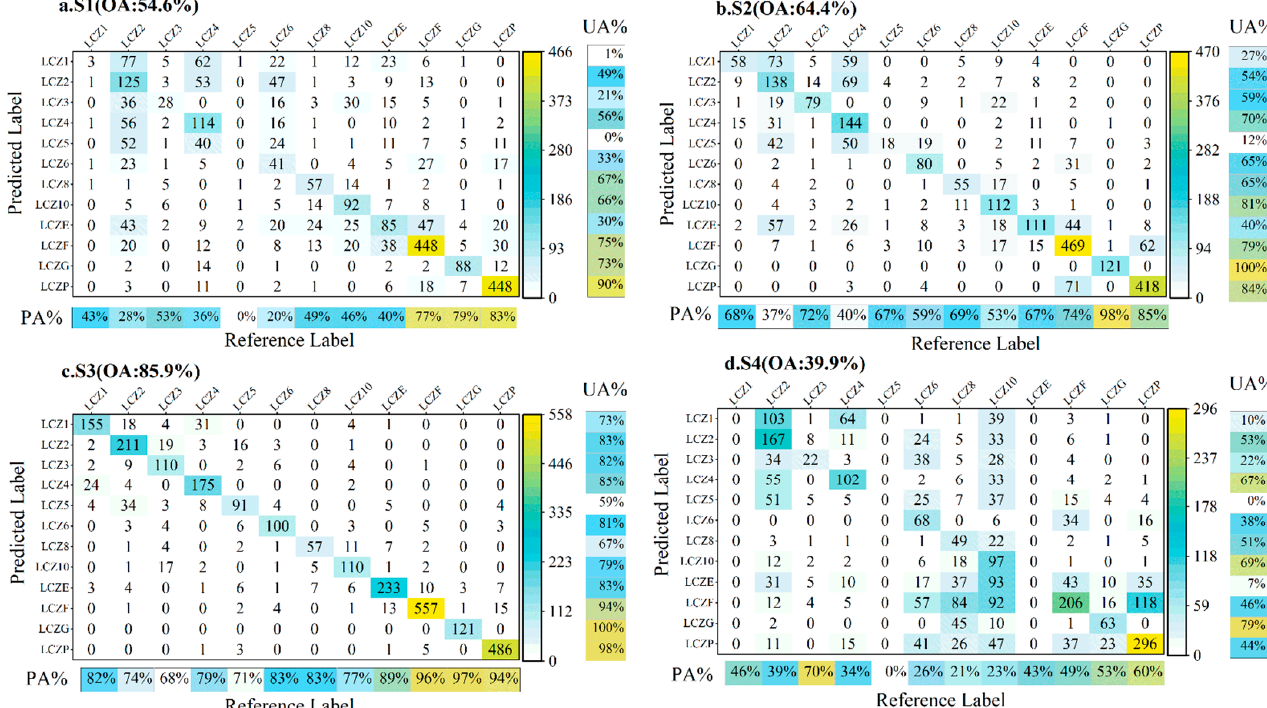
Figure 4. F1-score per class of LCZ in four schemes.